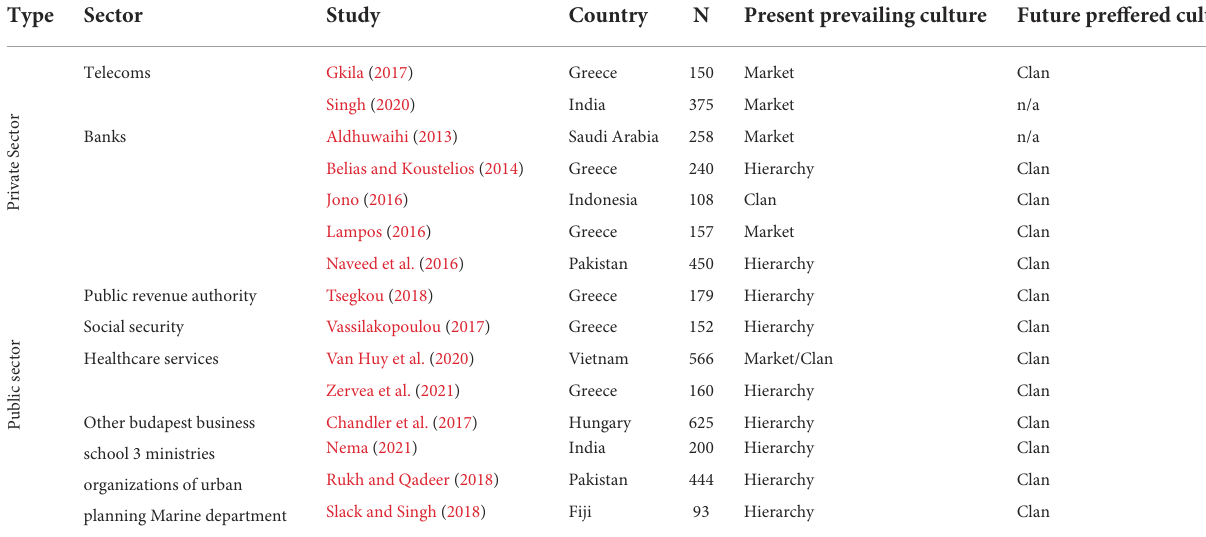
TABLE 1 International empirical evidence of OCAI studies in the sectors of our